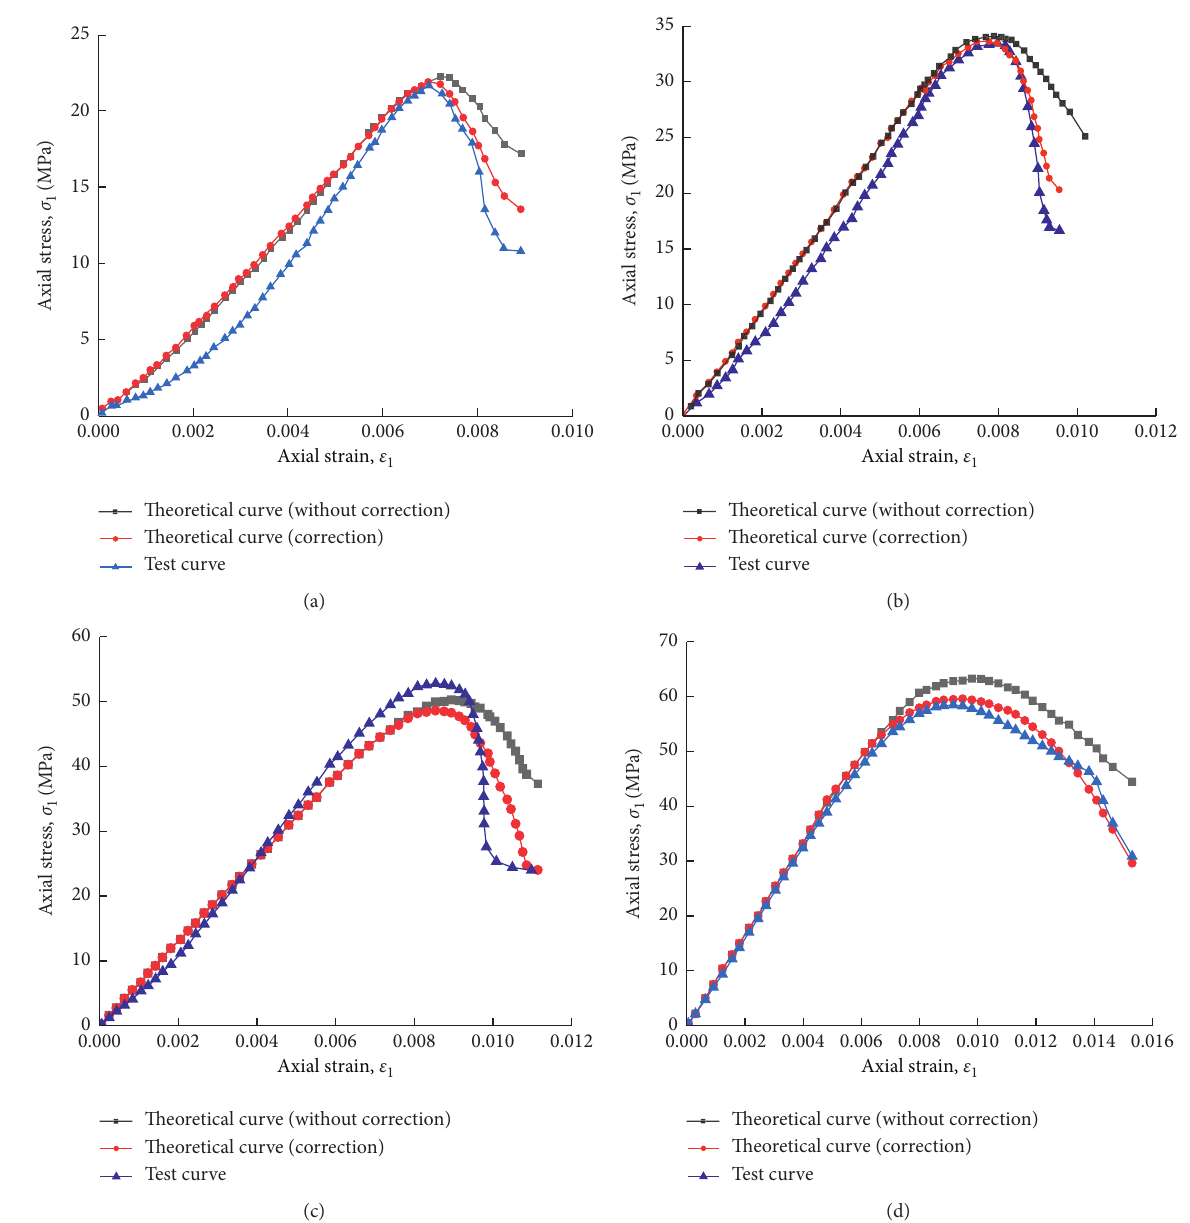
Figure 8: The curve of test pressure and date fitting under different confining pressures: (a) confining pressure 0MPa, (b) confining pressure 5MPa, (c) confining pressure 100MPa, and (d) confining pressure